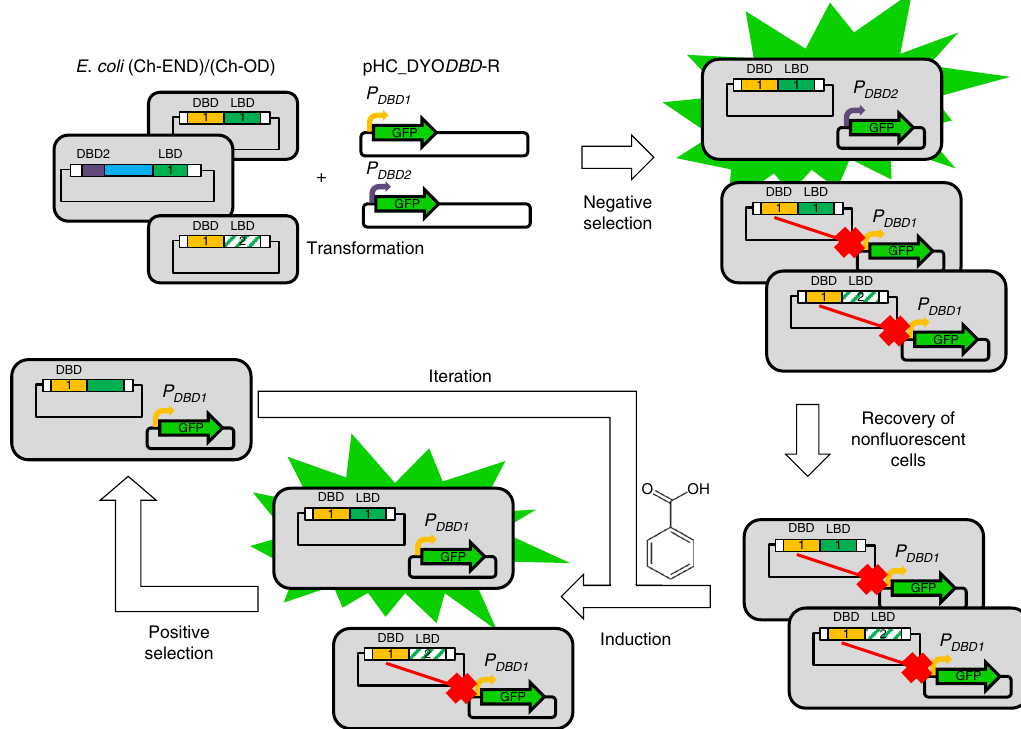
Fig. 3 Schematic representation of enrichment process. Chemically competent E. coli (Ch-END)/(Ch-OD) cells (gray rectangles) carrying vectors pCKTRBS/pCKTRBS-OD expressing chimeric TFs were transformed with reporter plasmids pHC_DYO DBD -R as described in Methods. The resulting cells were grown in LB media in the presence of aTc. Under this culture conditions the chimeric TFs were expressed. Every TF contains one out of 15 DBD. In the cells where the DBD of the chimera (represented as yellow and purple rectangles) was able to recognize the operator boxes of the reporter promoter (bent arrows in yellow and purple) introduced in pHC_DYO DBD -R, and it retained its DNA-binding capabilities, the expression of GFP is repressed. On the other hand, GFP was highly transcribed in the cells where the TF was not able to interact with the reporter promoter. The cells showing the lowest levels of GFP expression were recovered using the FACS enrichment described in Methods in the so called Negative Sorting. The recovered cells were grown in the presence of the inducer molecule (benzoate). TFs carrying a functional LBD were able to recognize the inducer and transduce that information to the DBD triggering a conformational change strong enough to detach the DBD from the DNA. Under these conditions bacteria carrying functional TFs would resume the transcription of GFP from the reporter promoter. A FACS sorting allowed to obtain a population enriched in the functional chimeras (Positive Sorting). This enrichment process was